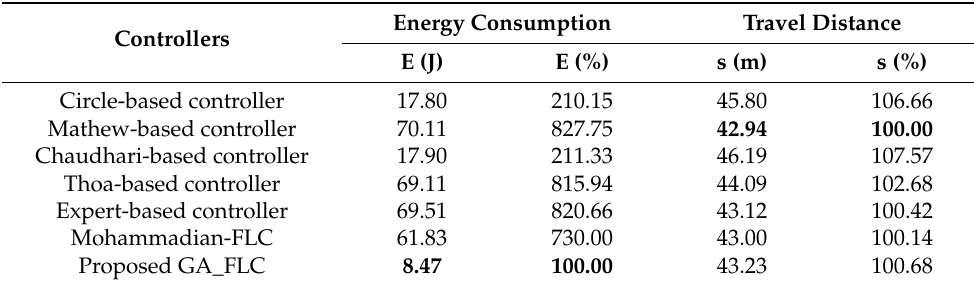
Table 12. Energy consumption and travel distance of the robot when the robot tracks the square path by the different controllers. Bold values are the best in the appropriate column.